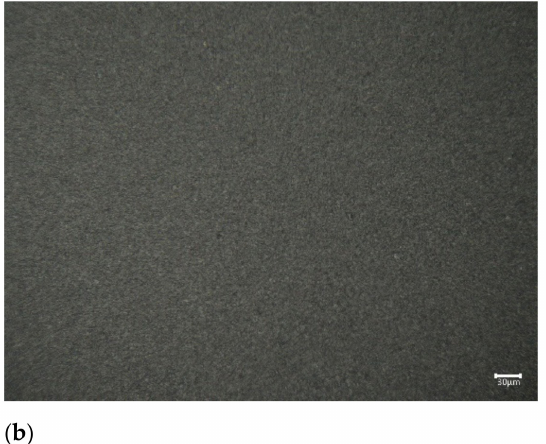
Figure 14. Observation of low loads and critical lapping surface. ( a ) Two-dimensional observation at 15 N; ( b ) two-dimensional observation at 20 N.